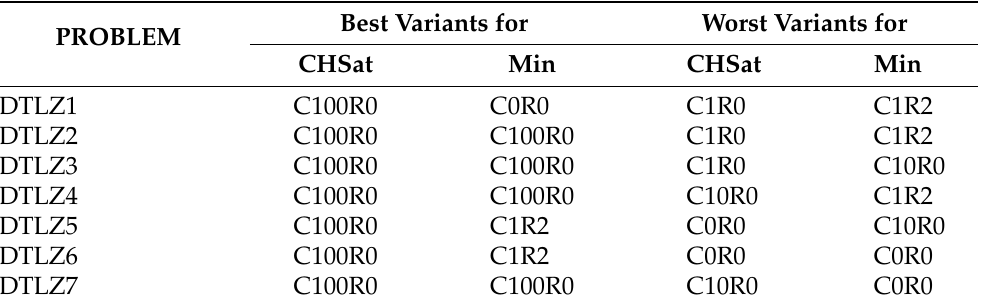
Table 5. Best and worst algorithms resulting from their statistical comparison evaluated with two